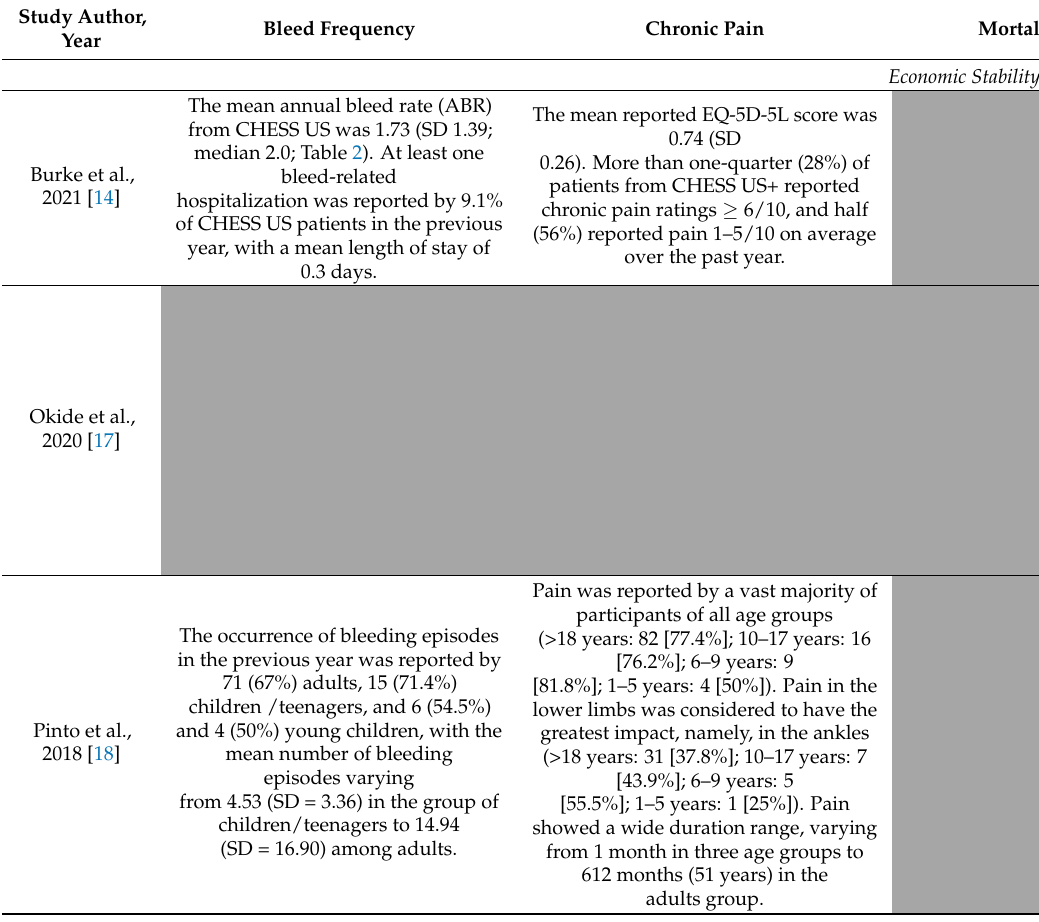
Table 7. Summary table of the SDOH components and respective clinical